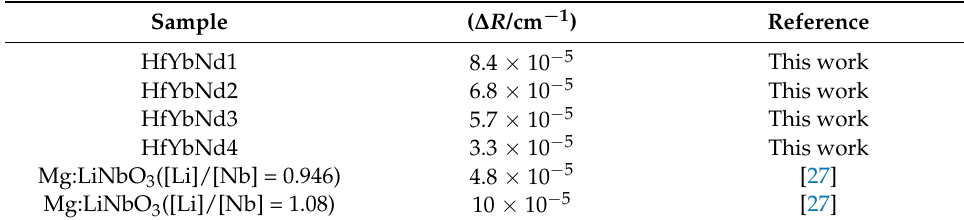
Table 2. The birefringence gradient of Hf:Yb:Nd:LiNbO 3 crystals. Sample